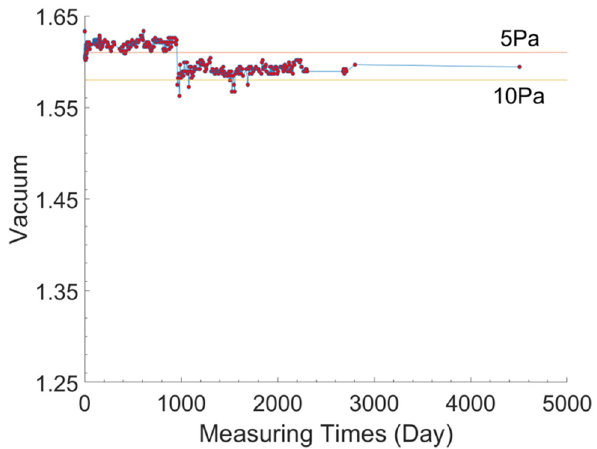
Figure 4: Relationship between vacuum holding voltage and time in vacuum packaging shell. According to the experimental data, the vacuum level kept fl uctuating in a stable range until day 954 while there was a signi fi cant decrease from the 954th day to the 961st day, and continued to fl uctuate in a stable range after the 961st day, until the 5,355th day, when the vacuum level remained at 1.5512. Data on the vacuum holding time of other packing shells are shown in the Appendix.